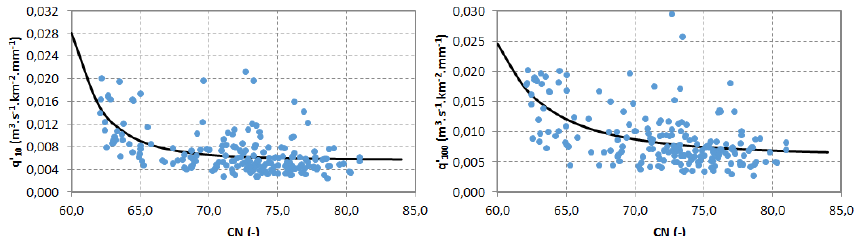
Figure 8. Relationship between catchment average CN value and peak discharge value per unit area and unit precipitation total for T = 10 years (left panel) and T = 100 years (right panel) with fitted lines following Eq.